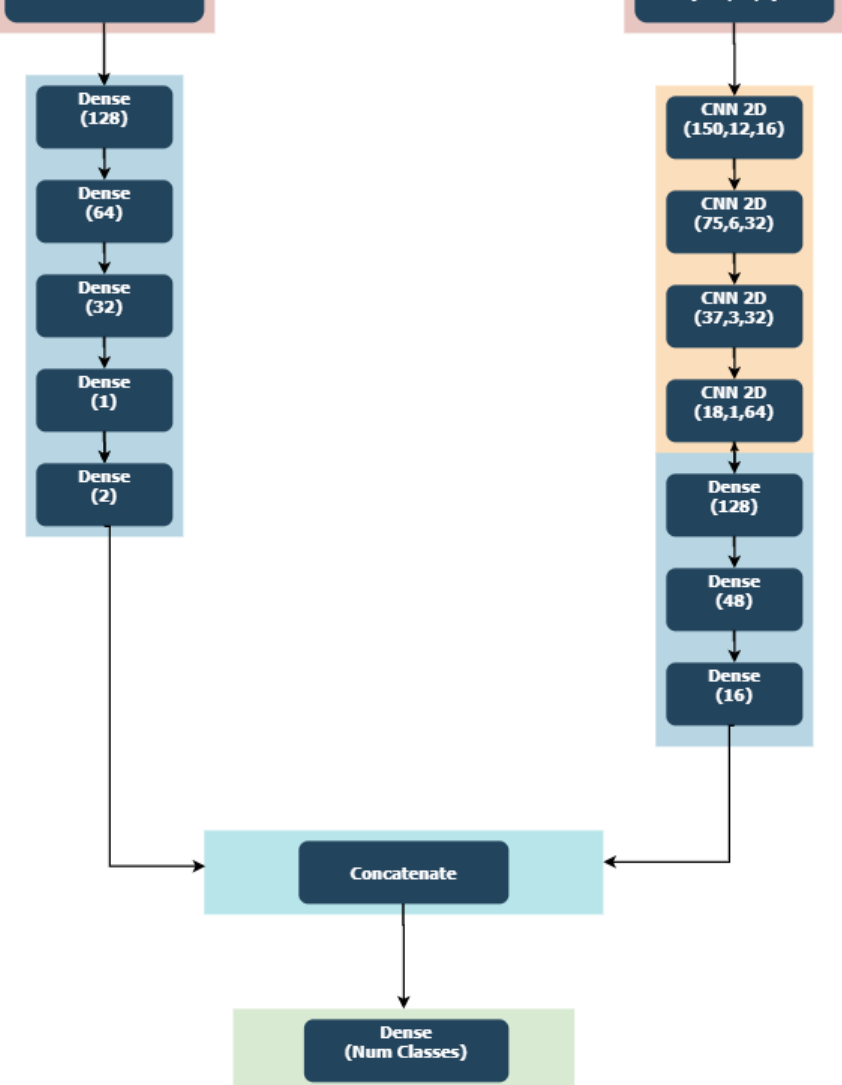
Figure 4. The multi-branch architecture of SPI-Net: the left branch focuses on the evolution of Geometric features relative to certain identified key-points over time. The second one focuses on the evolution of the spatial representation of skeletal key-points as a function of time in the Cartesian coordinate system. CNN 2D Blocks denote one 2D ConvNet layer (kernel size = 3), an AveragePooling layer and a Batchnormalization layer. Other Dense blocks are defined in the same format with a Batchnormalization layer following each Dense